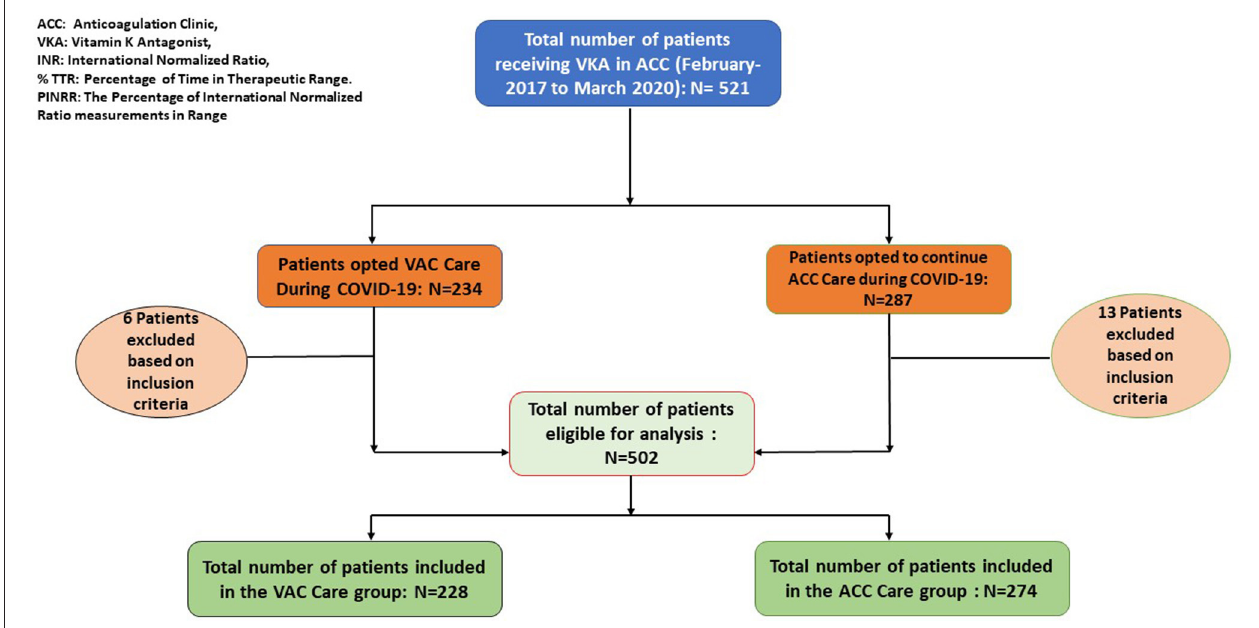
FIGURE 1 | Participant enrolment process. ACC, Anticoagulation clinic; VKA, Vitamin K Antagonist; INR, International Normalized Ratio; % TTR, Percentage of Time in Therapeutic Range; PINRR, The percentage of International Normalized Ratio measurements in Range. * EXCLUSION CRITERIA: Patients having less than 3 months of ACC exposure pre COVID-19 phase and less than 3 INR values were excluded from the study.